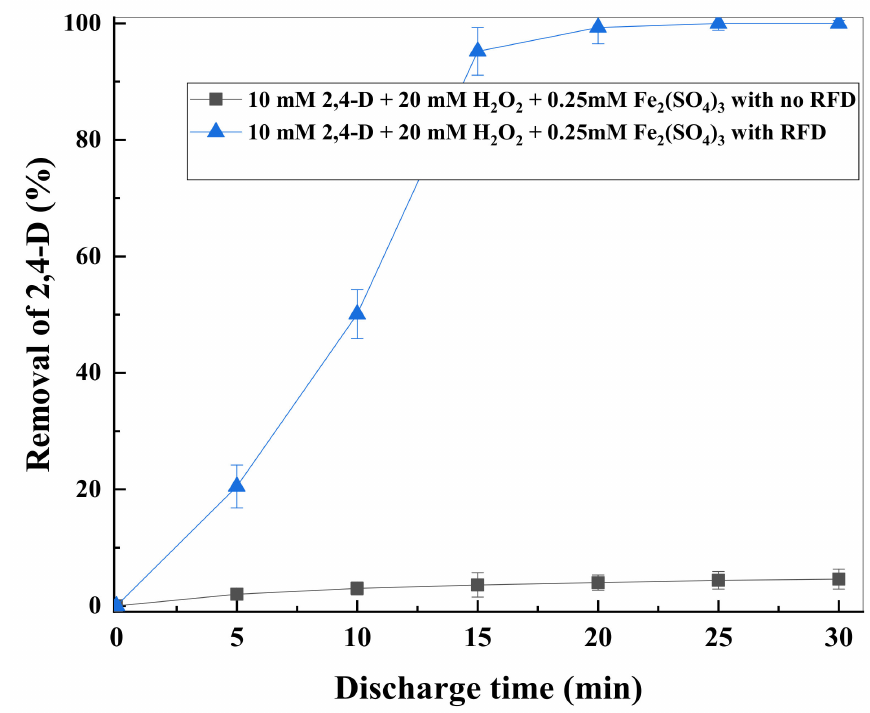
Figure 8. Accelerating effect of RFD for Fenton-like process (input power, 200 W; pH 0 , 2.0). It can be observed from Figure 8 that without RFD, little 2,4-D degradation proceeded.